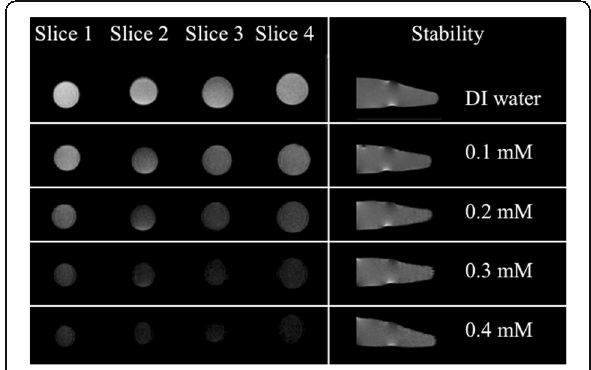
Fig. 10 T2-weighted MR phantom images of PEG-SPION in aqueous solution at human body temperature and using a 3.7-T MRI scanner, showing a low degree of sedimentation (range of 0.1 – 0.4 [Fe] mM) at the bottom of the